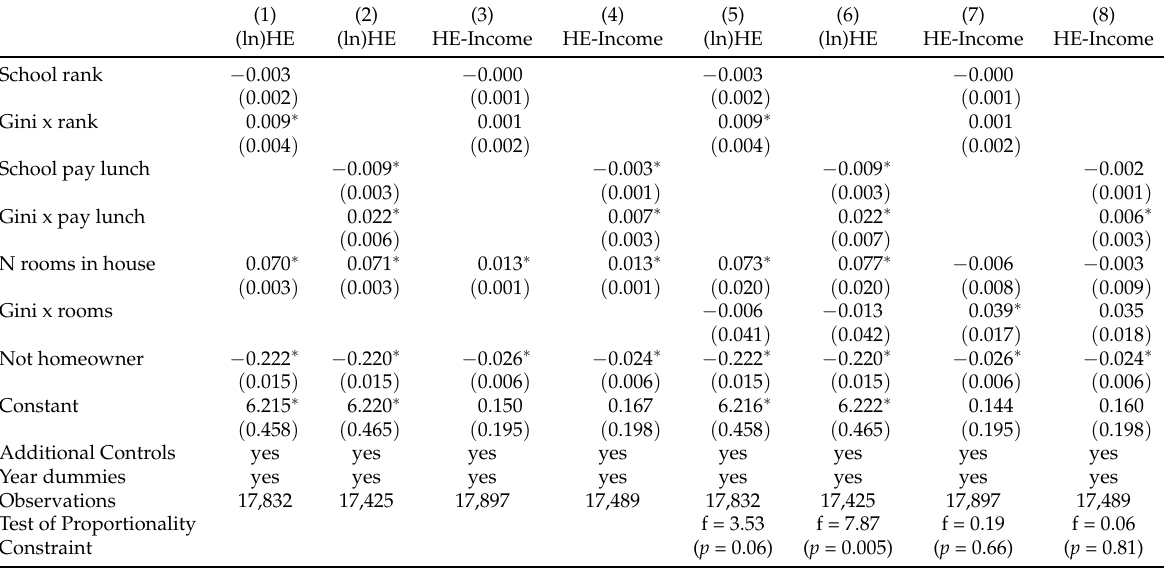
Table 3: Estimates from fixed-effects models of housing expenditures among parents with school-age children.